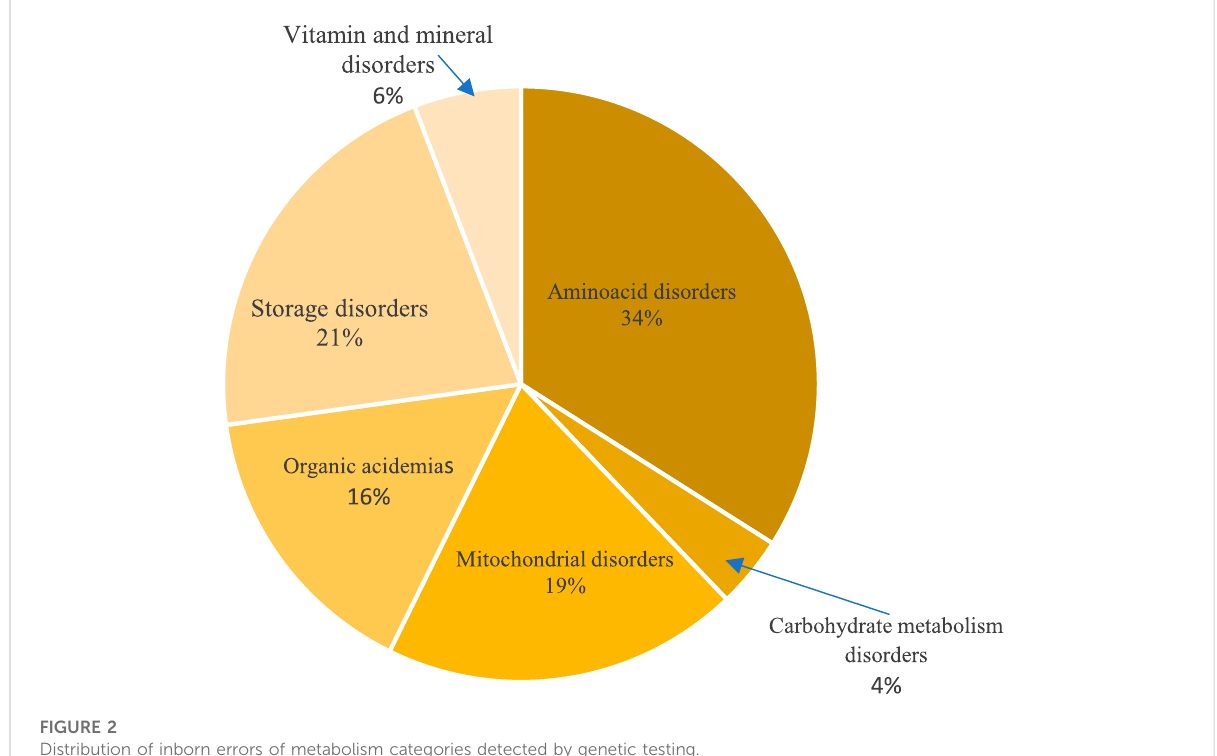
FIGURE 2 Distribution of inborn errors of metabolism categories detected by genetic